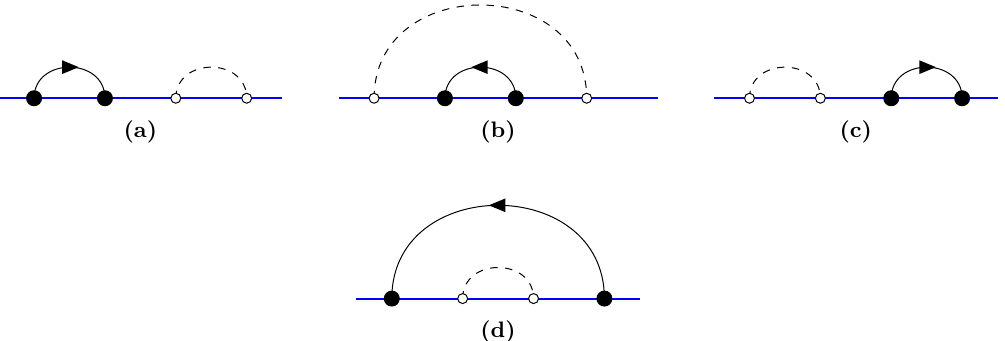
Figure 4. Diagrams with fermionic contractions (arrowed lines). White bubbles represent the two local operator insertions, whereas the black ones are the fermions from two L F superconnections coming from the second order expansion of W. The diagrams take into account all possible path orderings of the